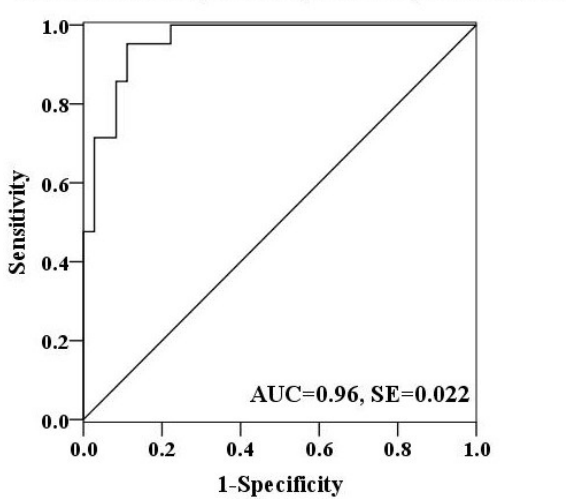
Figure 4. ROC curve for a combination of miR-17, miR-20a, miR-106a and miR-376c was constructed. The discriminating efficiency was apparently increased by combining above four miRNAs (AUC value: